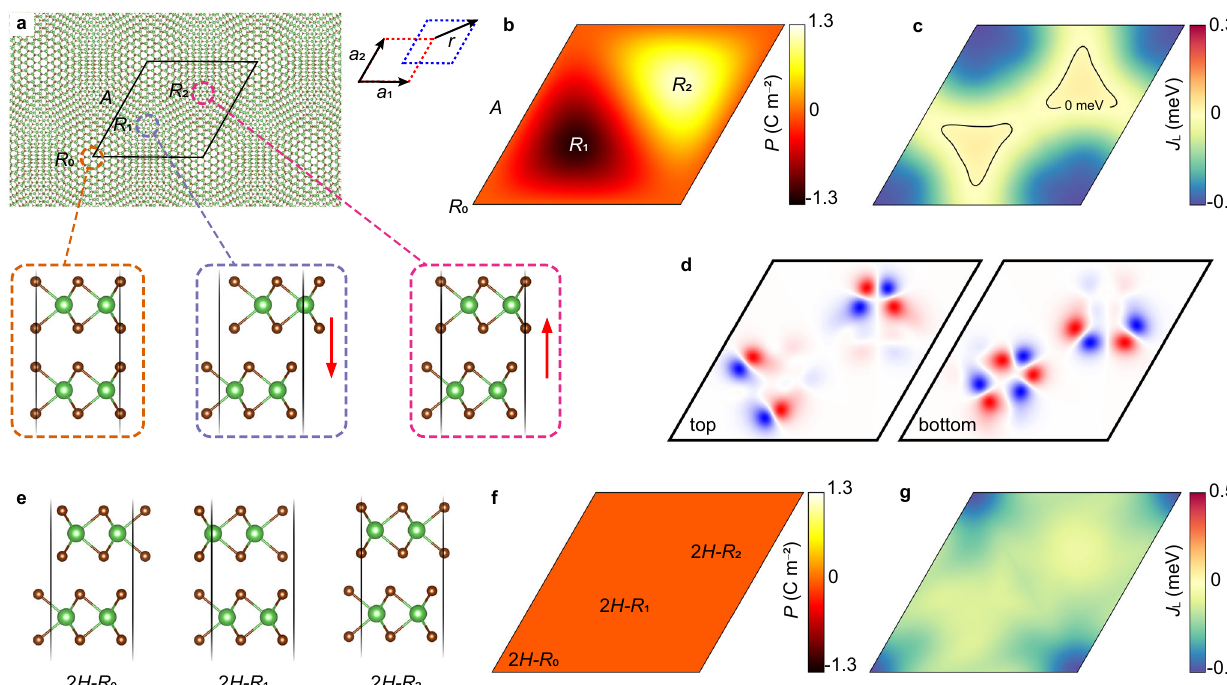
Fig. 5 The moiré pattern of LaBr 2 bilayer at small twisting angle. a The moiré superlattice of 3 R -type LaBr 2 bilayer from twisting. Three local regions R 0 , R 1 , R 2 stacking con fi guration are ampli fi ed to show their different interlayer con fi gurations in the moiré superlattice. b , c represent polarization and interlayer exchange interaction textures in 3 R -type LaBr 2 moiré superlattice, respectively. d is the magnetic texture at the twisting angle θ = 0.57°. e is the local regions R 0 , R 1 , R 2 stacking con fi guration for 2 H -type moiré superlattice, and the polarization ( f ) and interlayer exchange ( g ) texture formed in the 2 H -type moiré